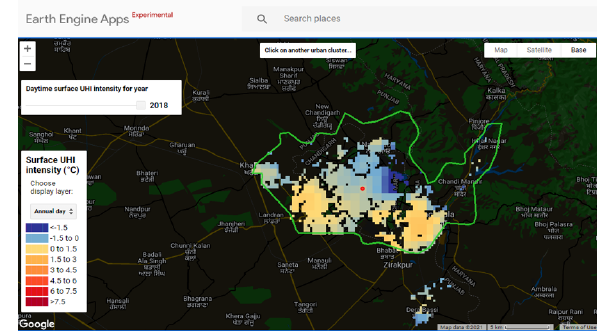
Figure 7: LST Estimation for Chandigarh City In figure-9 here, this graph on the left side Red Line in- dicates annual daytime and the blue line indicates annual night-time UHI intensity in degree Celsius, from the pe- riod 2003 to 2018, while the right corner graph shows the seasonal variability of UHI intensity between monthly day and night time UHI intensities in degree Celsius for the year 2018.